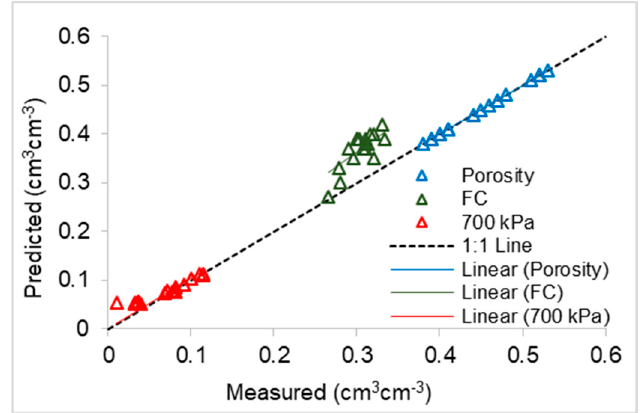
Figure 6. 1:1 Line graph of measured and predicted values of the porosity, field capacity (FC) and water content at − 700 kPa. Abbreviation: VSMC—volumetric soil moisture content.